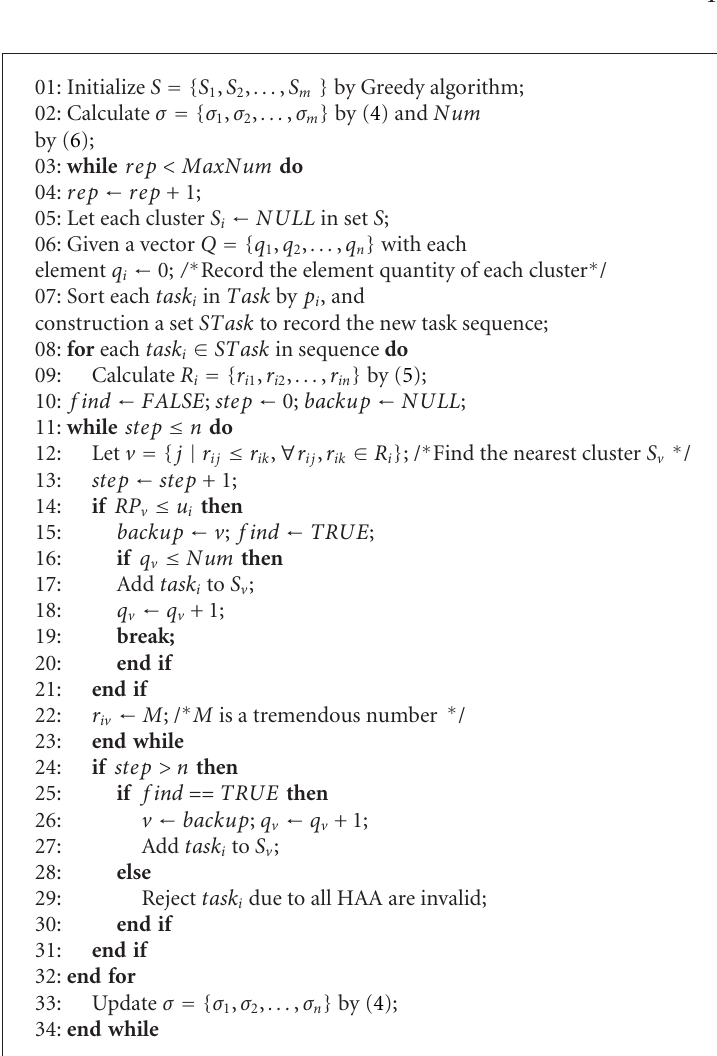
Algorithm 1: Pseudocodes of K-NGCA